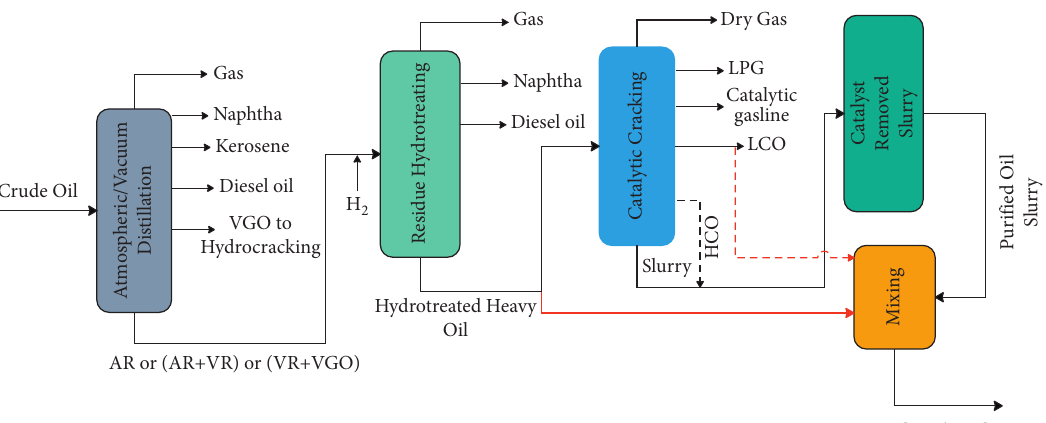
Figure 1: The flow chart of the marine low-sulfur fuel oil production process. AR: atmospheric residue; VR: vacuum residue; LCO: light circulate oil; HCO: heavy circulate oil; VGO: vacuum gas oil; and LPG: liquified petroleum gas.